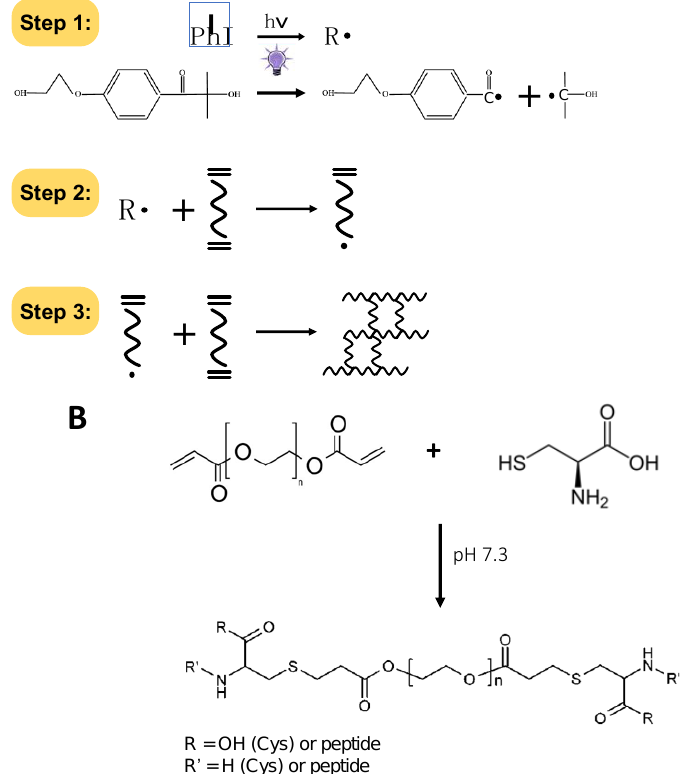
Figure 1. Schematic description of chemical reactions linked to the PhP damage. ( A ) Scheme of the reaction of free-radical formation from the photo-initiator (I) (step 1) leading to the photo- polymerization of the hydrogel by cross-linking (steps 2 and 3); ( B ) scheme of the Michael-type addition reaction to form the ester bond between the acrylate end-groups on PEGDA and the free thiols in the protein cysteines.